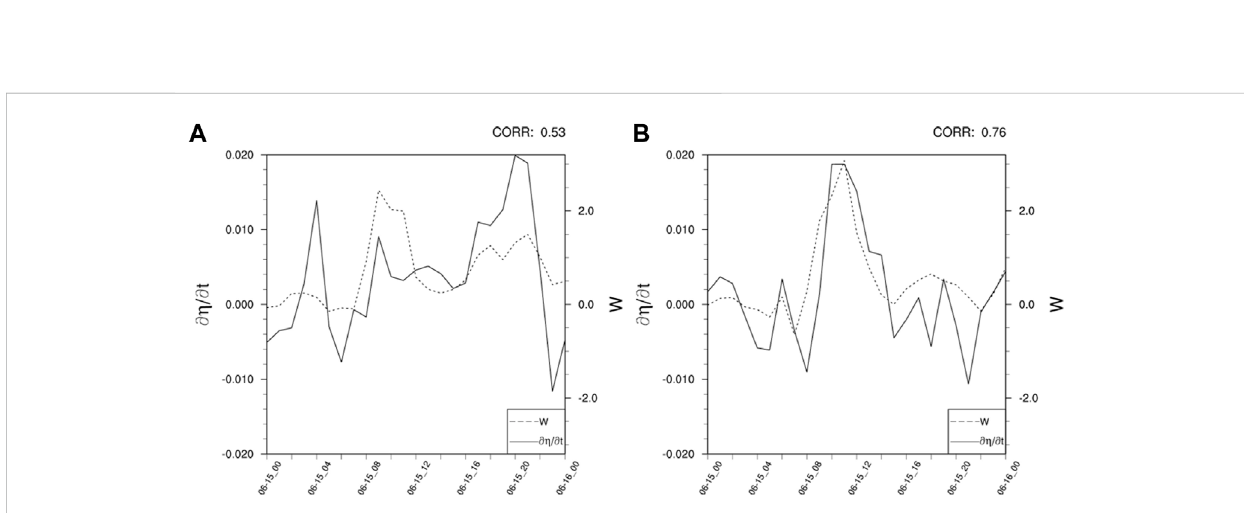
FIGURE 7 Time series ofthe domain mean ofthe localvertical pressure gradient force change (black solidline, units: m s − 3 )and vertical velocity change (black dotted line, units: m s − 1 ) integrated from (A) 3 km – 5 km and from (B) 5 km – 7 km. The values were averaged within 30 km × 30 km around 79 ° E, 37.15 ° N.